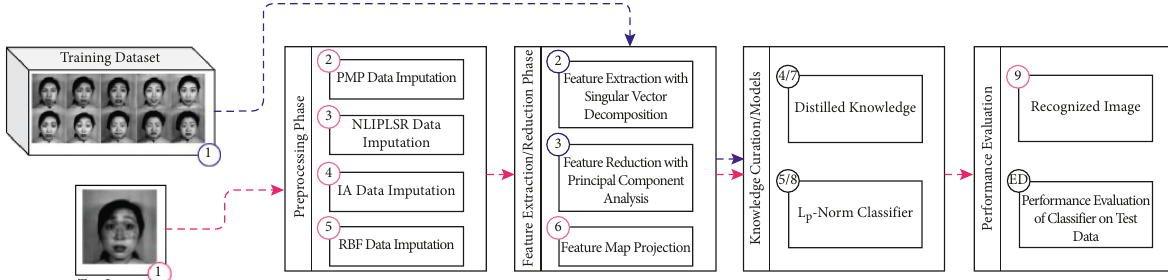
Figure 4: Research